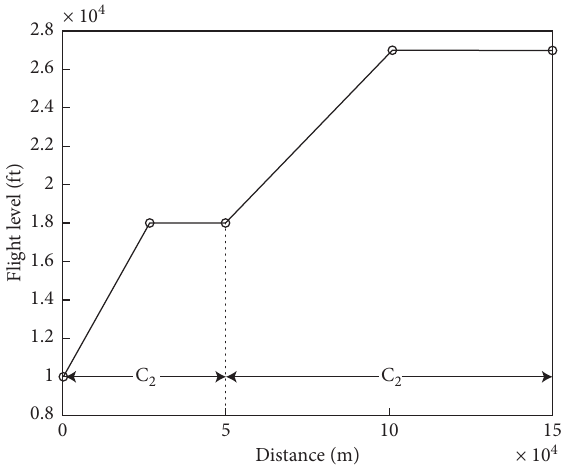
Figure 10: Optimal trajectory when w